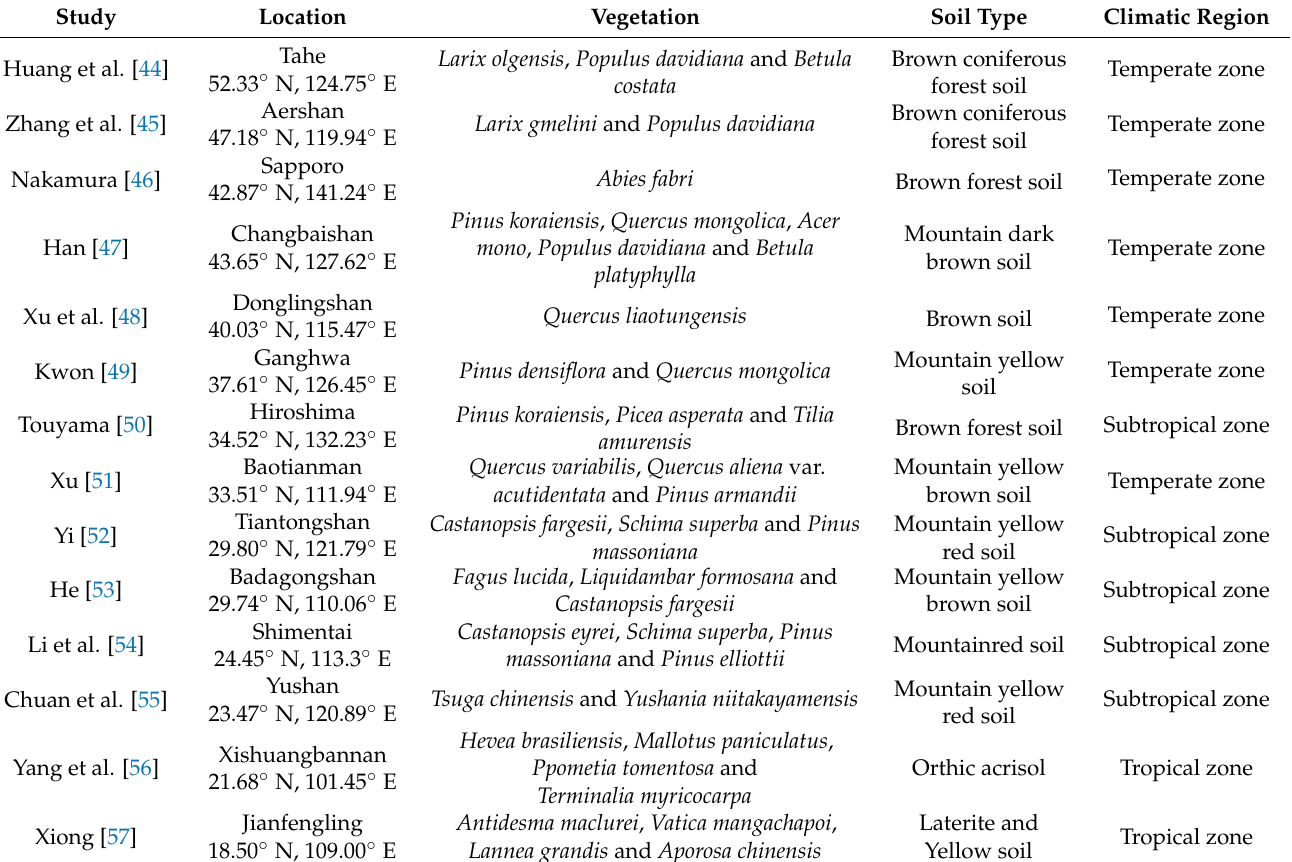
Table 1. Summary of the soil fauna community studies included in the dataset in East Asia.